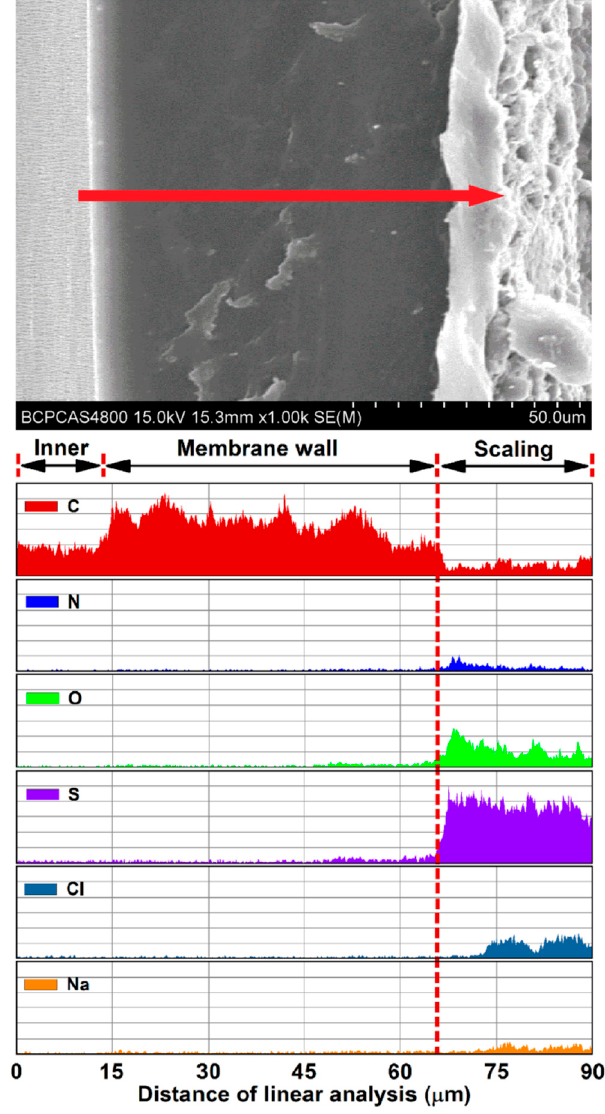
Figure 8. Elemental linear analysis of a cross-section of the fouled membrane sample.